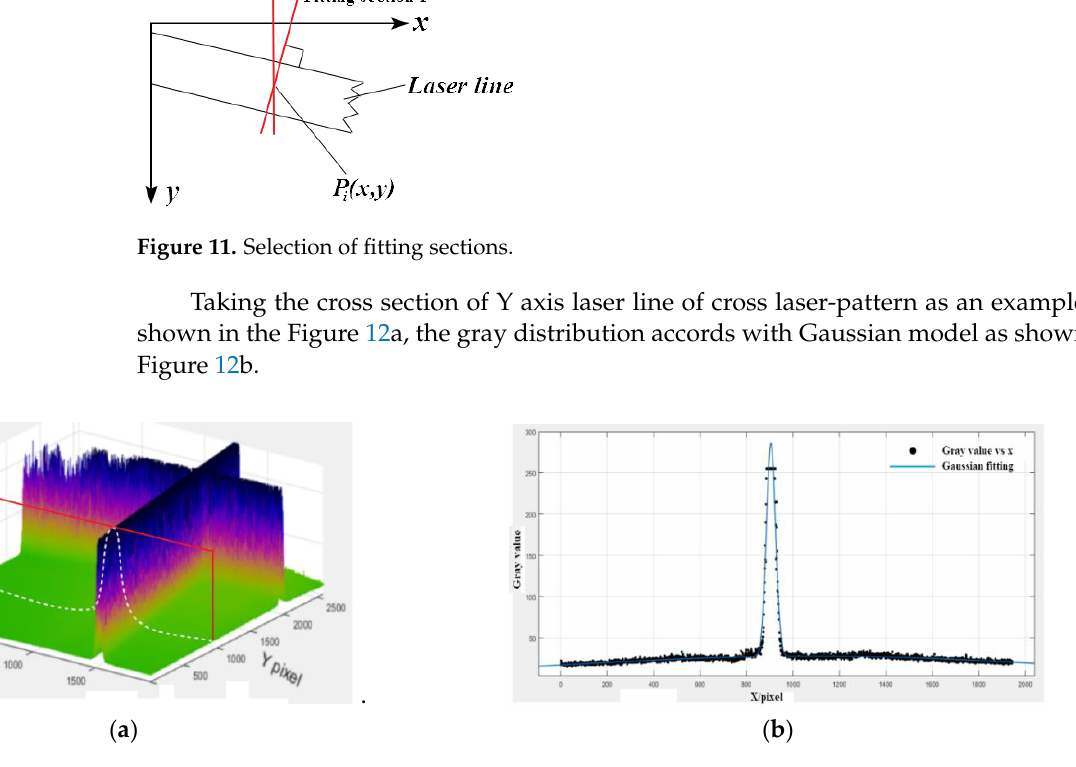
Figure 10. (a) Separation result of X axis line. (b) Separation result of Y axis line.